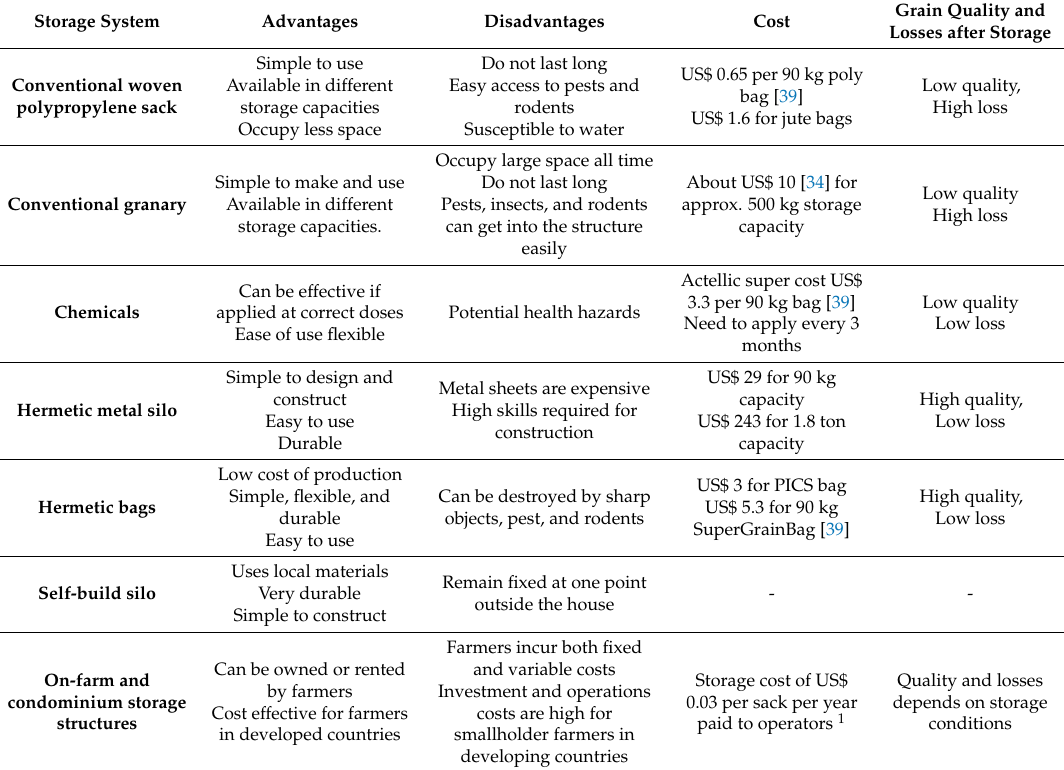
Table 5. Advantages and disadvantages of different grain storage practices for smallholder